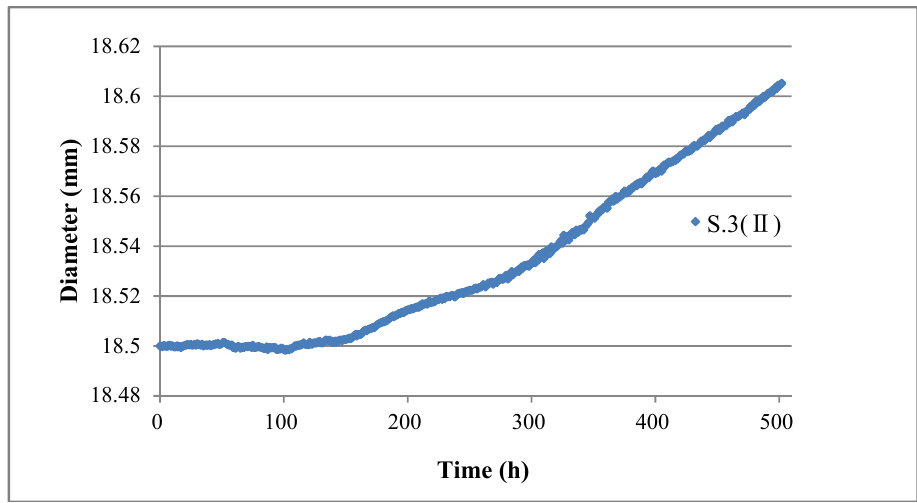
Figure 20. Monitored diameter of sensor S.3 (II).